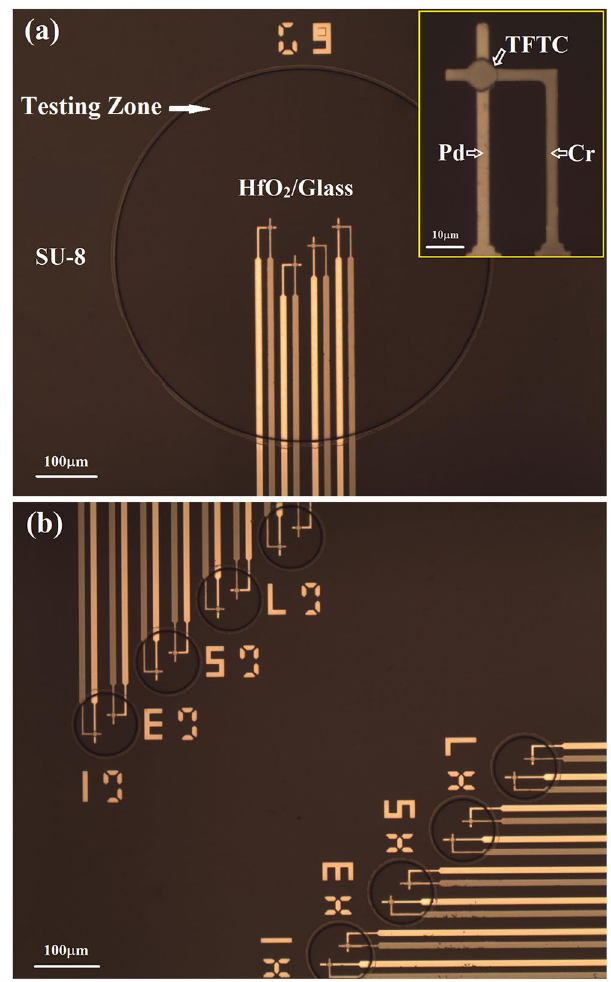
Figure 2. Optical photographs of different Testing Zones. ( a ) A bigger Testing Zone with a diameter of 600 μ m. It contains 4 Pd/Cr micro-TFTCs. The inset presents one of the Pd/Cr micro-TFTCs for details. The darker stripe is Cr stripe, the brighter stripe is Pd stripe. The stripe width is 3 μ m. The overlapping junction on the top is the hot-end of the micro-TFTC. It has a diameter of 8 μ m. ( b ) Two arrays of smaller Testing Zone with a diameter of 100 μ m. Each Testing Zone contains 2 Pd/Cr